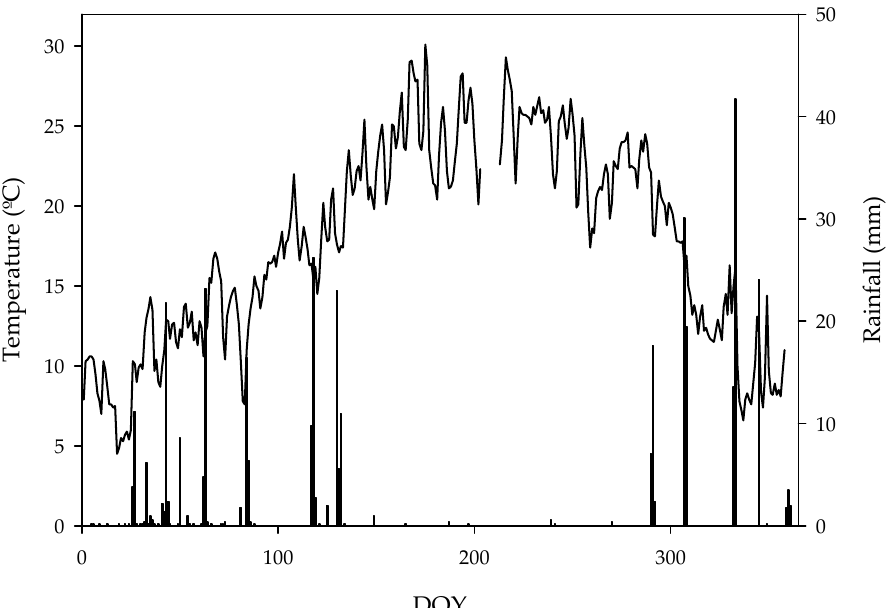
Figure 2. Annual pattern of daily mean air temperature and rainfall. Data were obtained from the “IFAPA Los Palacios” station, which is approximately 6 km away from the experiment site. This meteorological station is part of the Andalusian agroclimatic stations network (Junta de Andalucía).